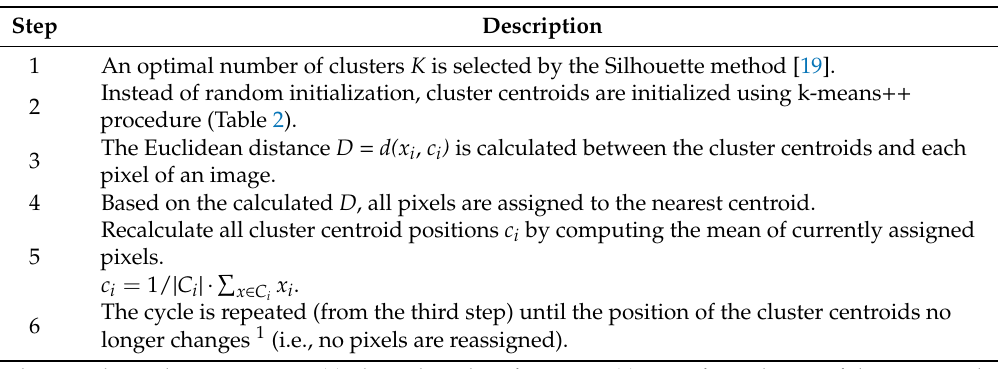
Table 1. The k-means clustering method.